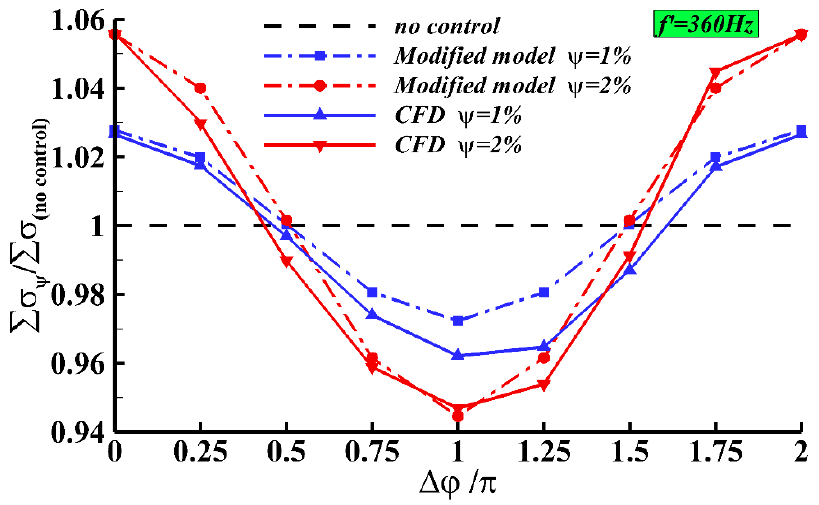
Figure 17. Control effects of modified model and CFD simulation under different phases, and amplitudes.